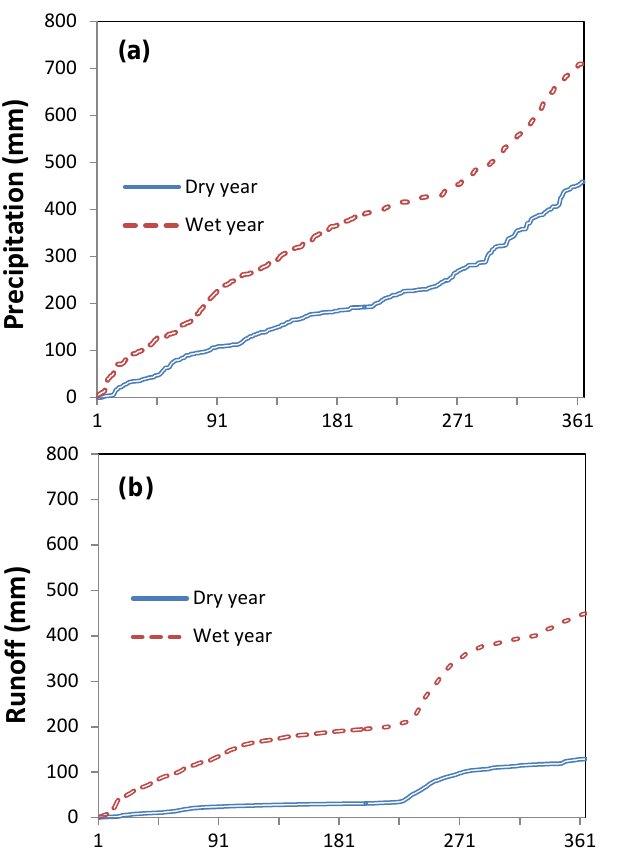
Figure 2. Cumulative plots of (a) precipitation and (b) runoff in dry (1995, 2002, 2005 and 2010) and wet (1987, 1992, 2000 and 2001) hydrologic years. The hydrologic year is 1 September (day 1) to August 31 of the following year (day 365). The cumulative plots shown here represent the average for all the dry and wet years noted above.